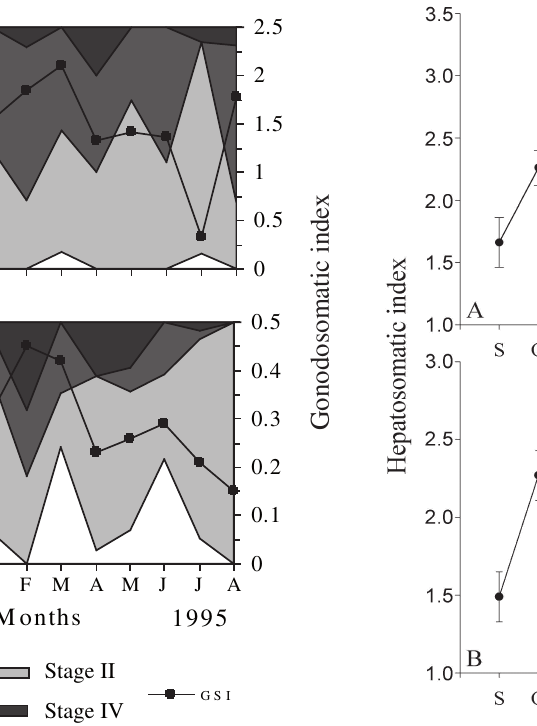
F IG . 4. – Monthly variation in the mean HSI for adult male (A), and female (B) H. plumieri